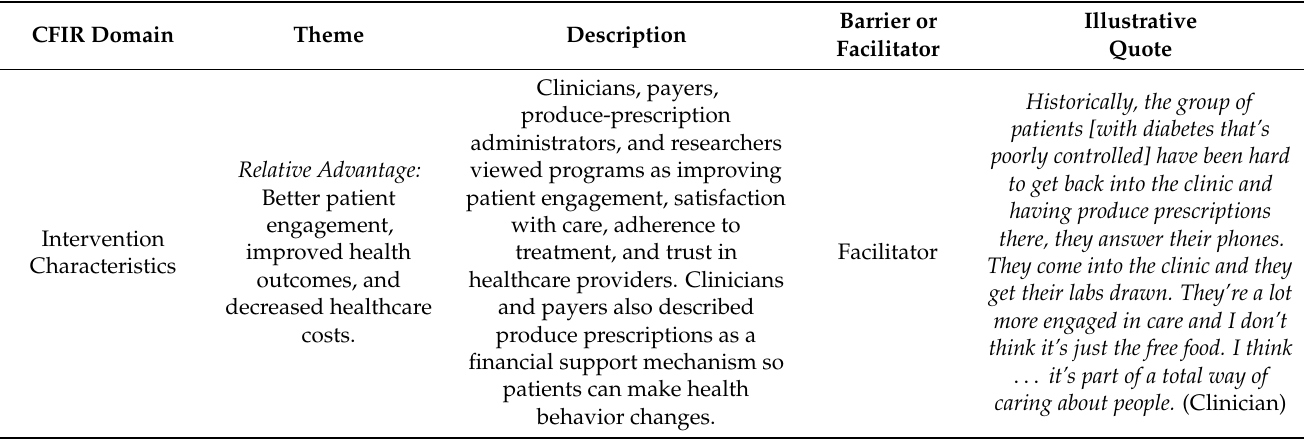
Table 2. Description of themes by CFIR